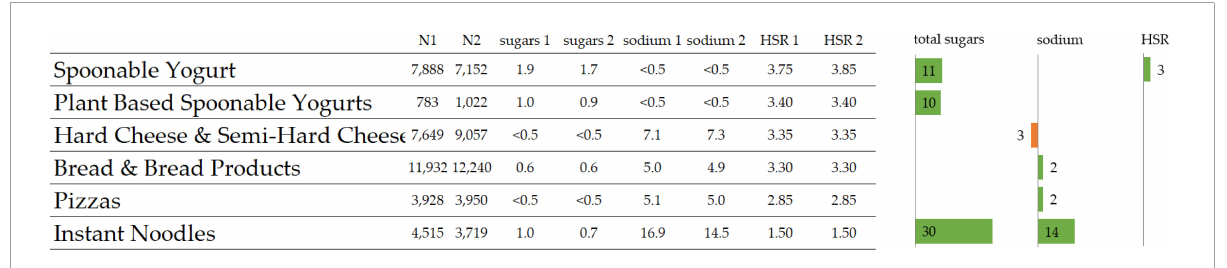
FIGURE3 Six selected Mintel categories, Number of products N1 for 2016–2018 and N2 for 2018–2020, mean HSR points for total sugar and sodium, mean HSR, and relative improvement between the two periods as bar charts.